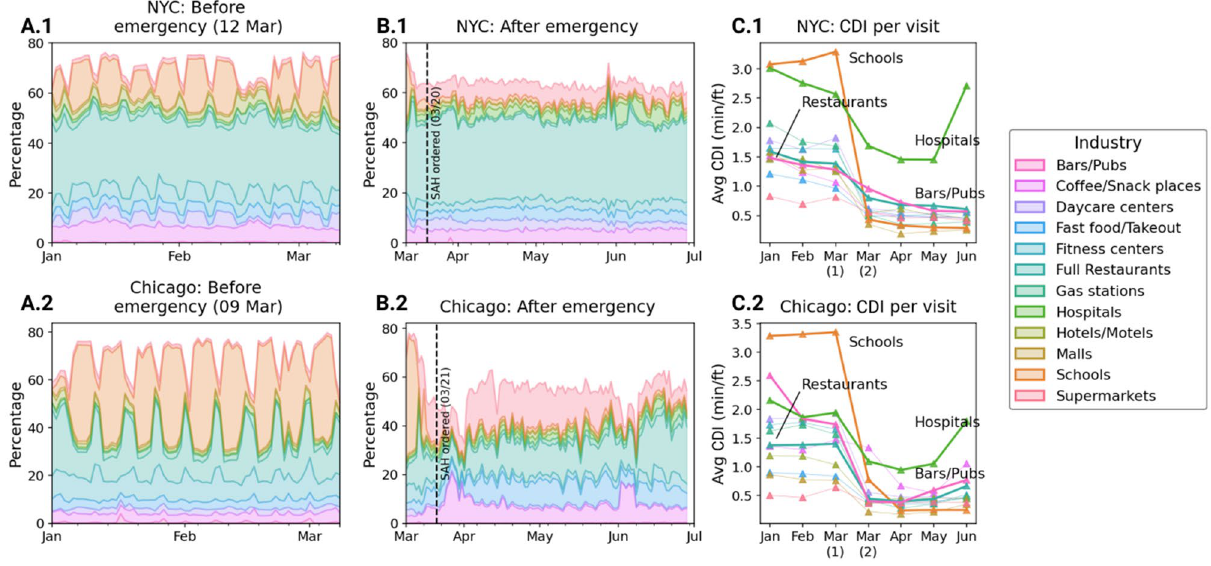
Figure 6. Contribution of CDI by industry. Proportion of total daily CDI attributable to the 12 industries of interest in the study cities ( A ) before and ( B ) after the declaration of emergency. The other industries contribute the remainder of the CDI, denoted by the empty region in the chart areas. ( C ) Monthly change in average CDI per visit in the two cities, with March divided into two parts (before and after March